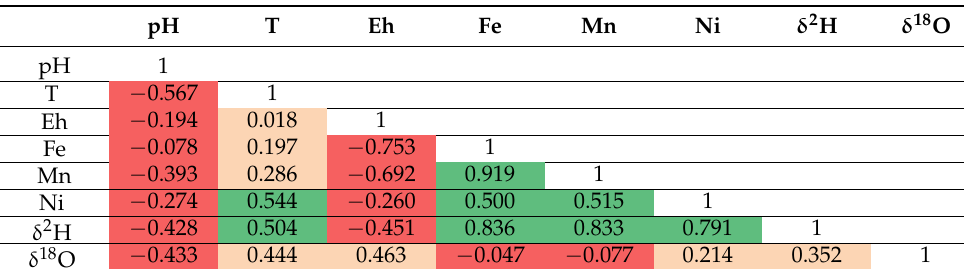
Table 3. Pearson correlation matrix for Case History I (in red fair correlation, in orange moderate correlation and in green high correlation).